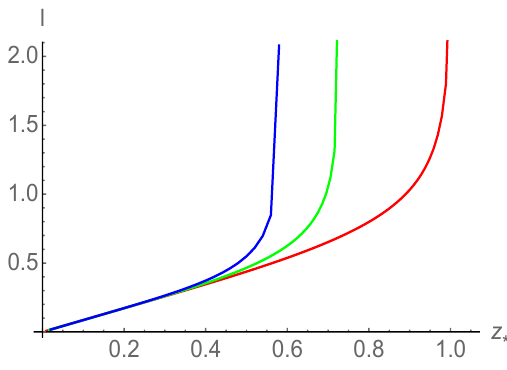
Figure 35 . ‘ as a function of z (cid:3) in the dual de- con(cid:12)nement phase of the large black hole. Here (cid:22) = 0 and red, green and blue curves correspond to T=T c = 1 : 2, 1 : 6 and 2 : 0 respectively. In units GeV.